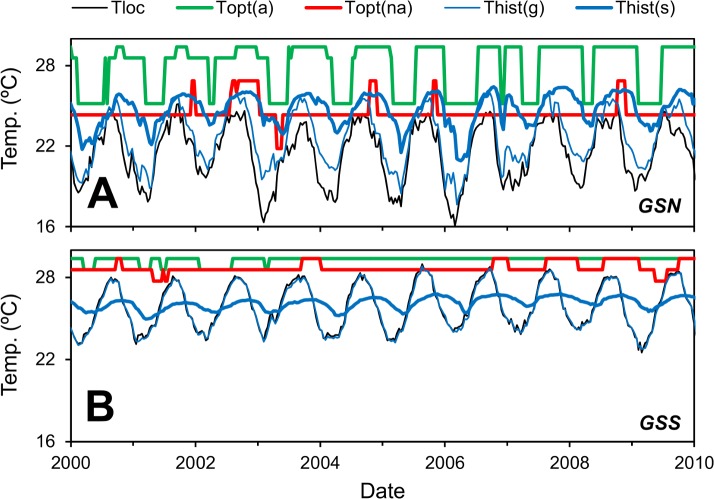
Time series of model results.Local temperature (Tloc), optimum temperatures of the most abundant species in simulations with (Topt(a)) and without(Topt(na)) advection and historical temperature based on growth (Thist(g)) and selection (Thist(s)) rates at two locations in the Gulf Stream (GSS and GSN in Fig 3). Population average growth rate = 0.14 d-1.